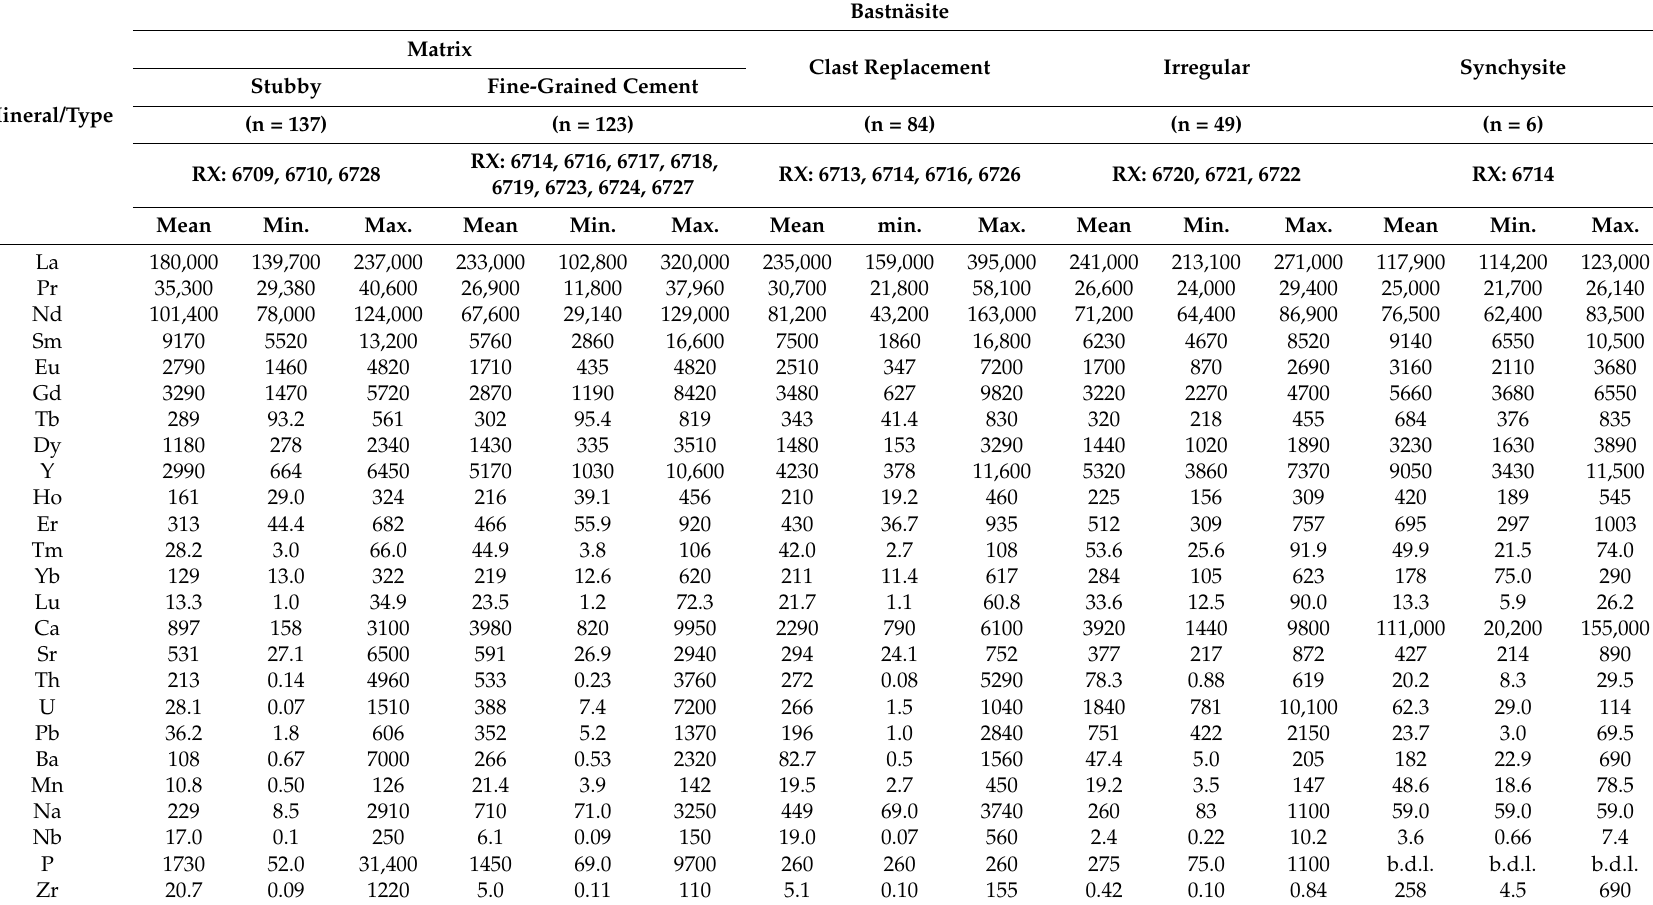
Table 3. Summary of LA-ICP-MS trace element data for bastnäsite and synchysite. Mean, minimum (min), and maximum (max) values for major mineral groupings (in